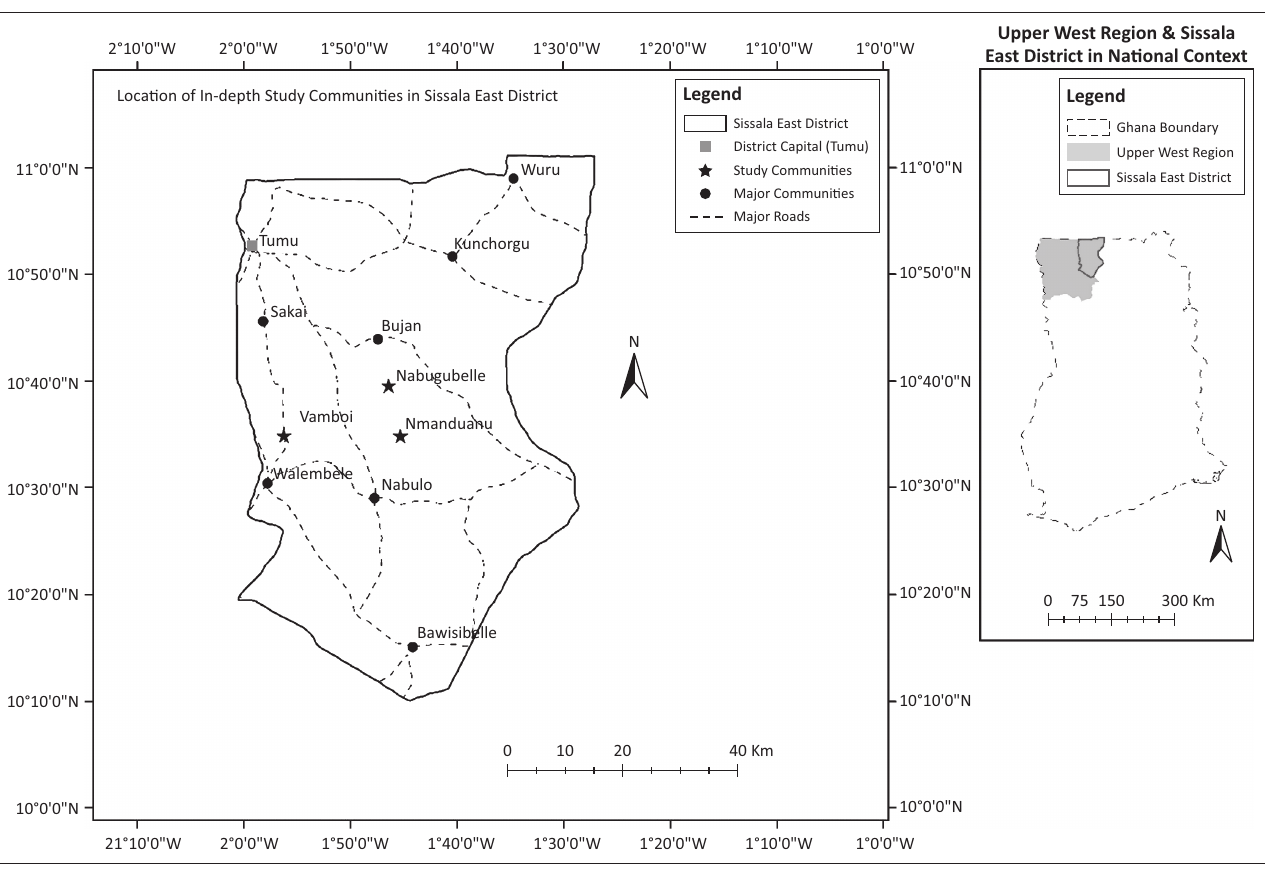
FIGURE 1: Map showing study area in national